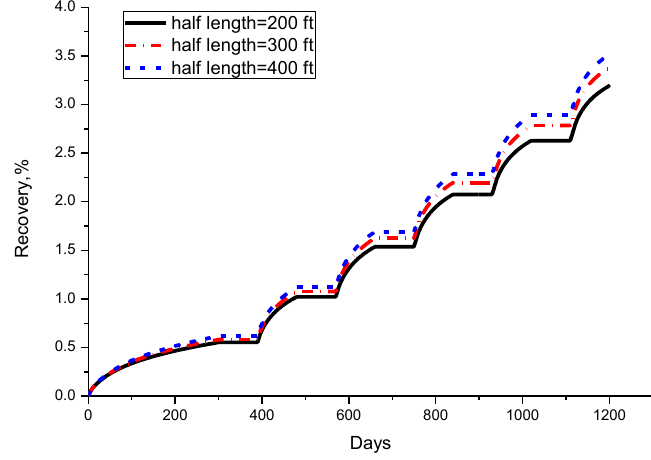
Figure 12. Recovery of different hydraulic fracture lengths.